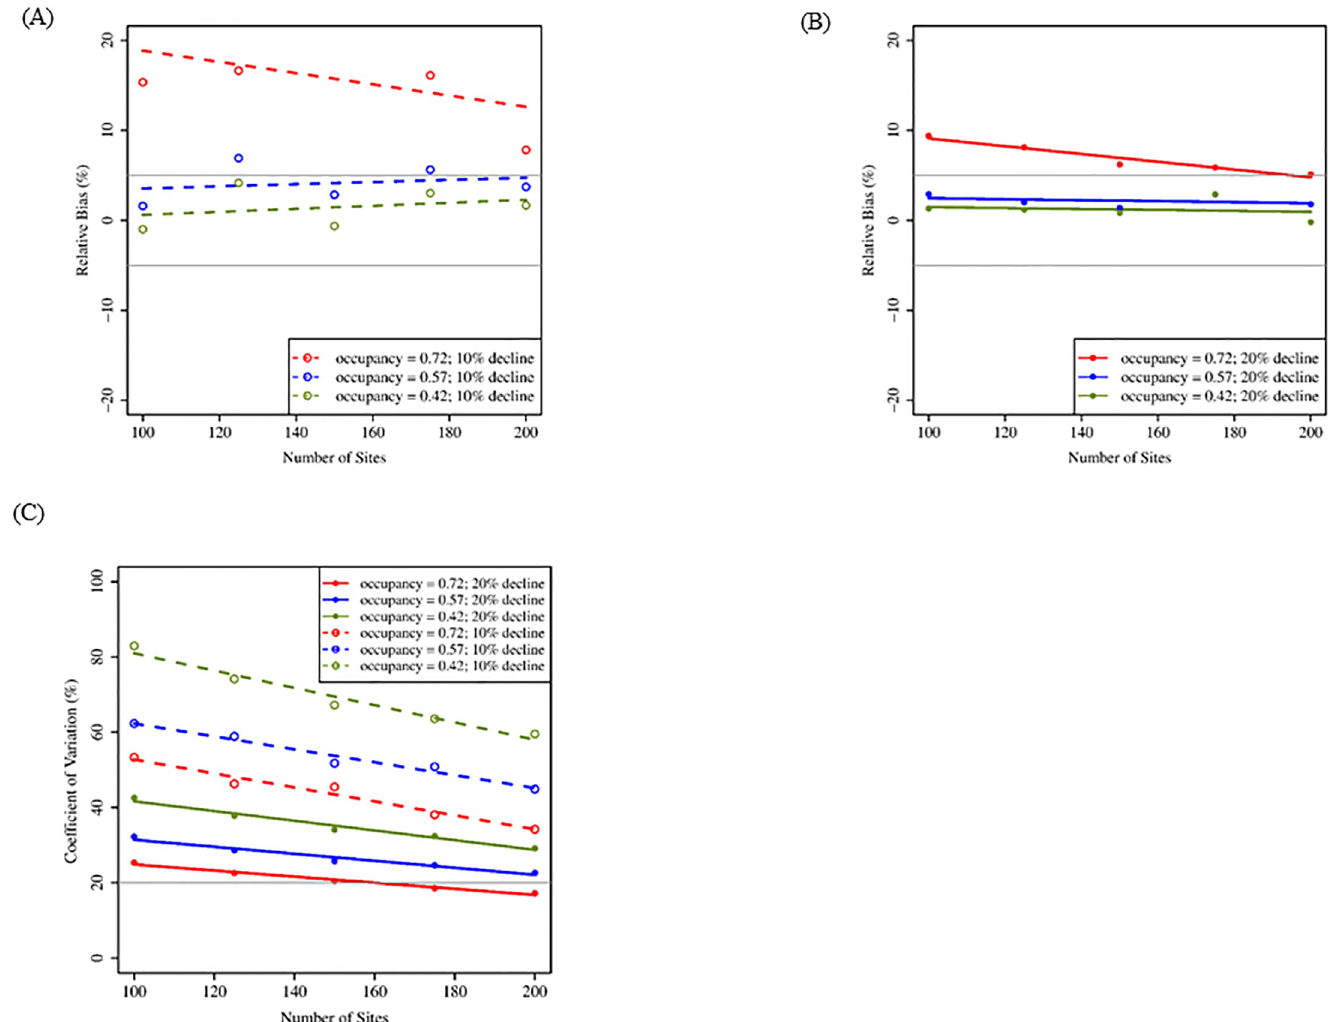
Fig 1. Mean relative bias and coefficient of variation for simulations increasing number of sites (removal design; 20 years). Mean relative bias (A: 10% decline; B: 20% decline) and coefficient of variation (C) for 100–200 sites, three initial occupancy rates, and two rates of population decline following a 20-yr period, assuming a maximum of three visits and a probability of detection = 0.67. These results reflect removal sampling in which territories are not visited after they are confirmed to be occupied within a given breeding season. Gray lines indicate benchmark values for respective metrics (Table 2).